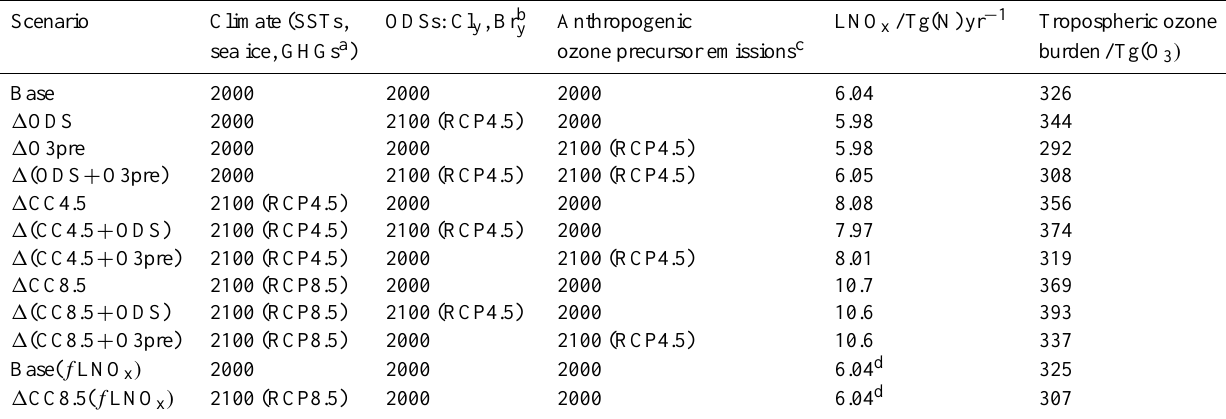
Table 1. List of model simulations. The final two columns are averages over the 10-year simulation periods. Scenario